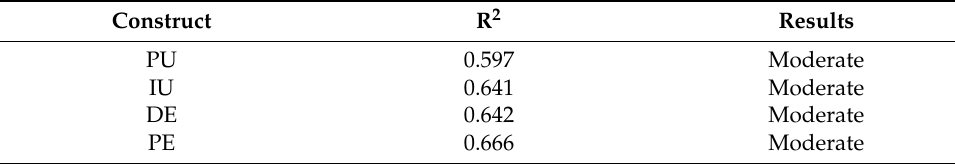
Table 7. R 2 of the endogenous latent